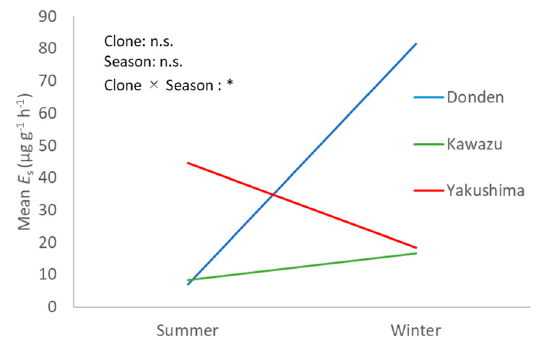
Figure 4. Interaction between seasons and clones in the ozone exposure group. The results of the two- way ANOVA are shown in the upper left area. Asterisk (*) indicates statistical differences ( 𝑝 (cid:3407) 0.05 ). n.s., not significant. The interaction between clone and season was significant, which suggests that there was different seasonal change in each clone after ozone exposure.